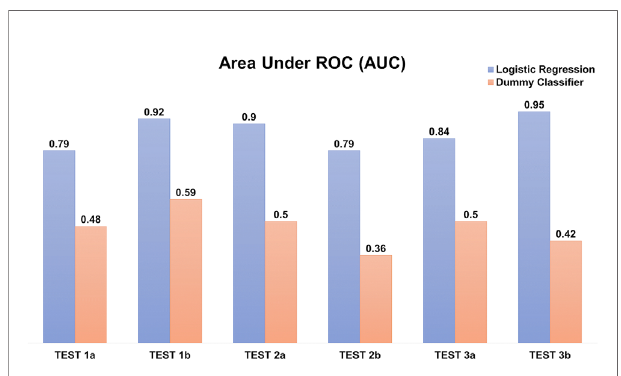
FIGURE 8 | Logistic regression model to predict the recombinant antibody production rates using amino acid counts. The prediction is evaluated using Area under the ROC (AUC) in triplicates, each with two independents (A, B) testing datasets. The “ dummy ” classi fi er is used as a